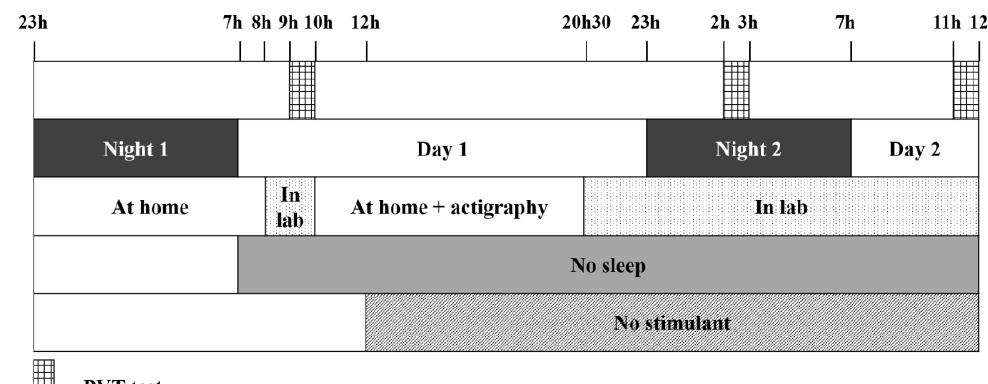
Figure 1. Data acquisition protocol. The first horizontal line represents the times when the participants had to perform a Psychomotor Vigilance Test (PVT). The second line refers to the succession of nights and days, and the third line shows when the participants were at home and in the lab. The two last lines indicate from what time the participants were sleep deprived and could no longer consume any